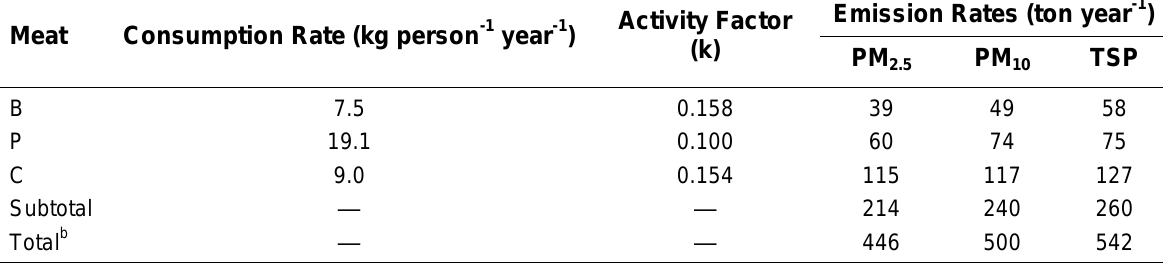
, PM , and TSP in Seoul, Korea a 2.5 10